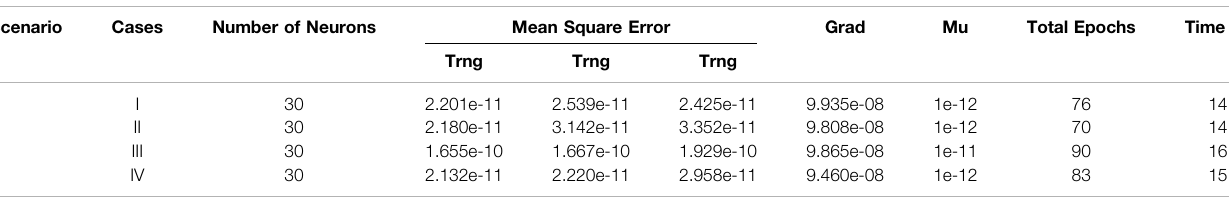
TABLE 6 | Numerical performance indicators for scenario III.